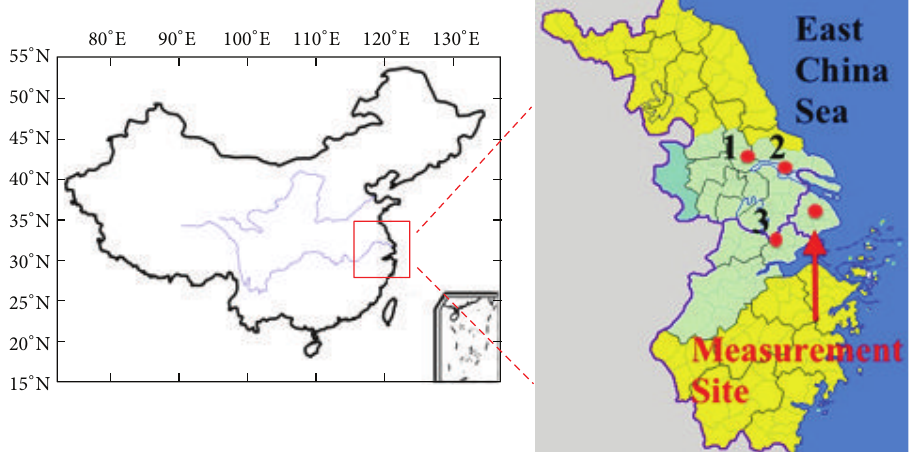
Figure 1: Location of the measurement site in Shanghai. Locations 1, 2, and 3 are Yangzhou (NW of Shanghai), Nantong (NNW of Shanghai), and Jiaxing (SW of Shanghai).